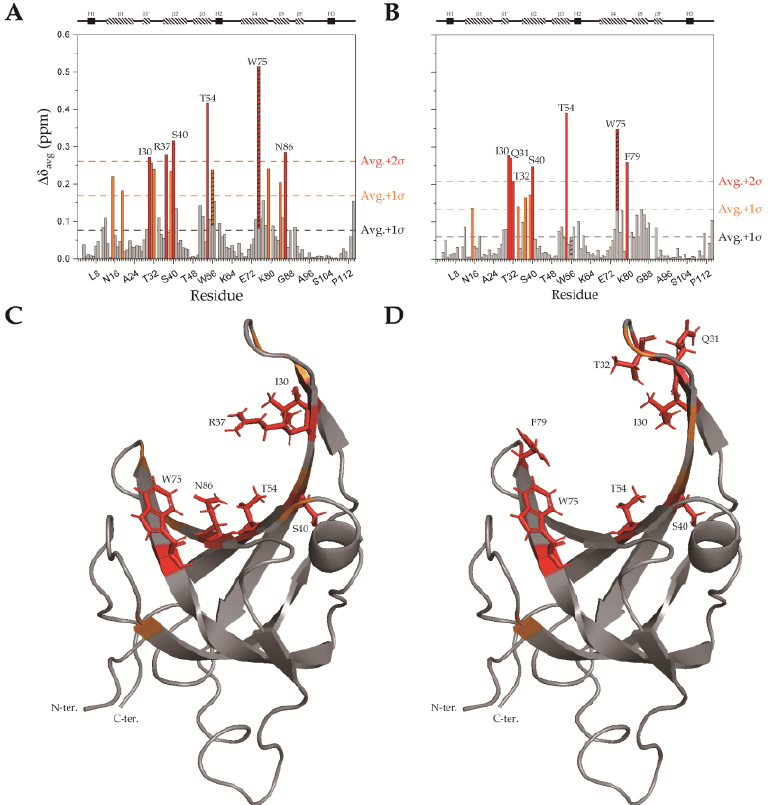
Figure 5. DNA binding site of SsoSSB 1–114 . ( A , B ) Chemical shifts of 15 N-labeled SsoSSB 1–114 at a concentration of 500 µ M were perturbed upon ssDNA titration. Average CSP values ( ∆ δ avg ) for each residue of SsoSSB 1–114 with 1 mM ssDNA at ( A ) 25 ◦ C and ( B ) 50 ◦ C are shown. Trp sidechain CSPs are indicated with hatched bars. The secondary structure from UniProt is shown at the top of each graph. ( C , D ) The solution structure of SsoSSB 1–114 (PDB ID: 7WCG) was colored based on CSP data at ( C ) 25 ◦ C and ( D ) 50 ◦ C. Color coding is the same as in panels A and B. Sidechains are displayed for residues with the largest CSPs.